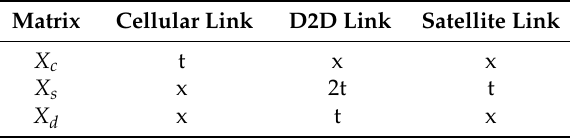
Table 1. Time required for packet